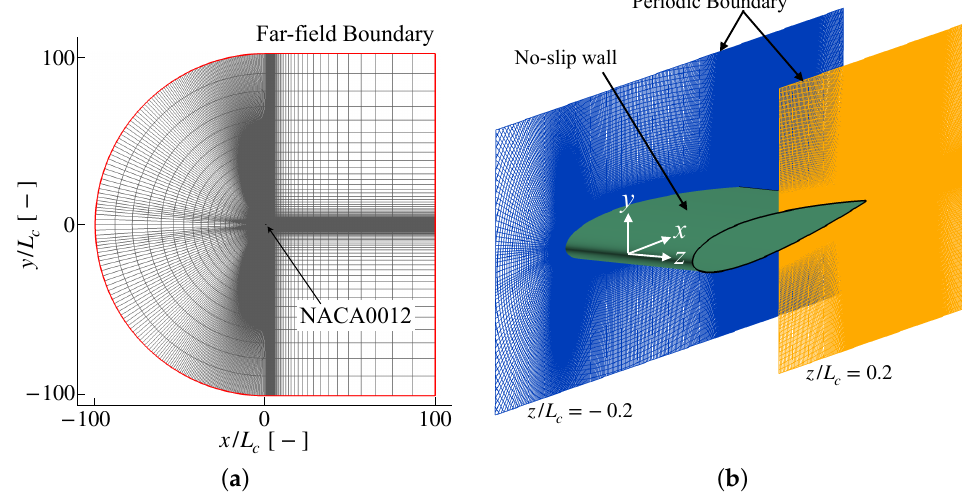
Figure A1. Numerical grid for the simulations. ( a ) Whole area; ( b ) Near the